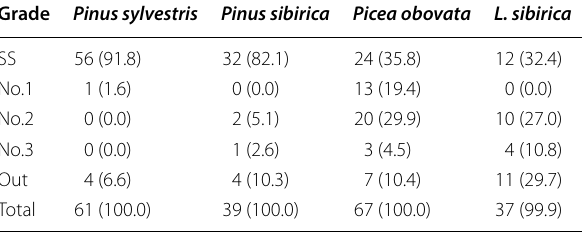
SS, select structural; Out, out of grade. Values in parenthesis indicate frequency percentage of each grade